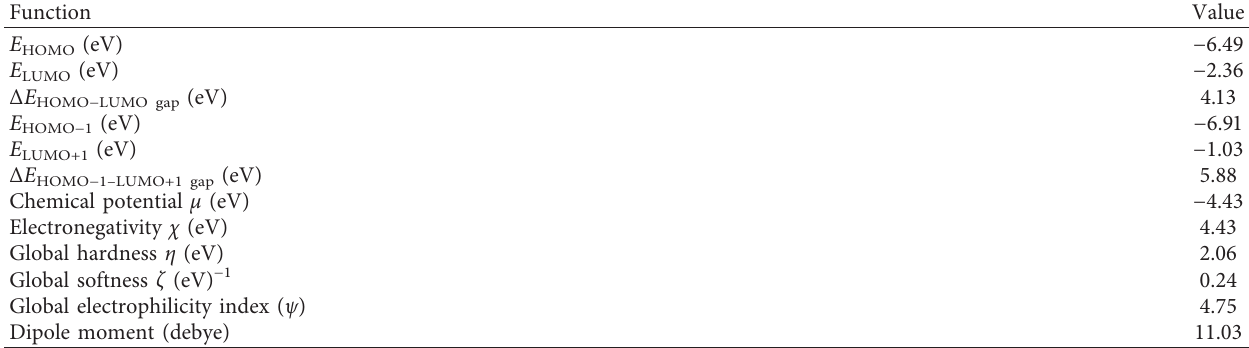
Table 5: TD-DFT/B3LYP/6–311++G(d,p) calculations of HOMO-LUMO energy gap, chemical potential, electronegativity, global hardness, global softness, electrophilicity index, and dipole moment performed in DMSO solvent within the IEFPCM